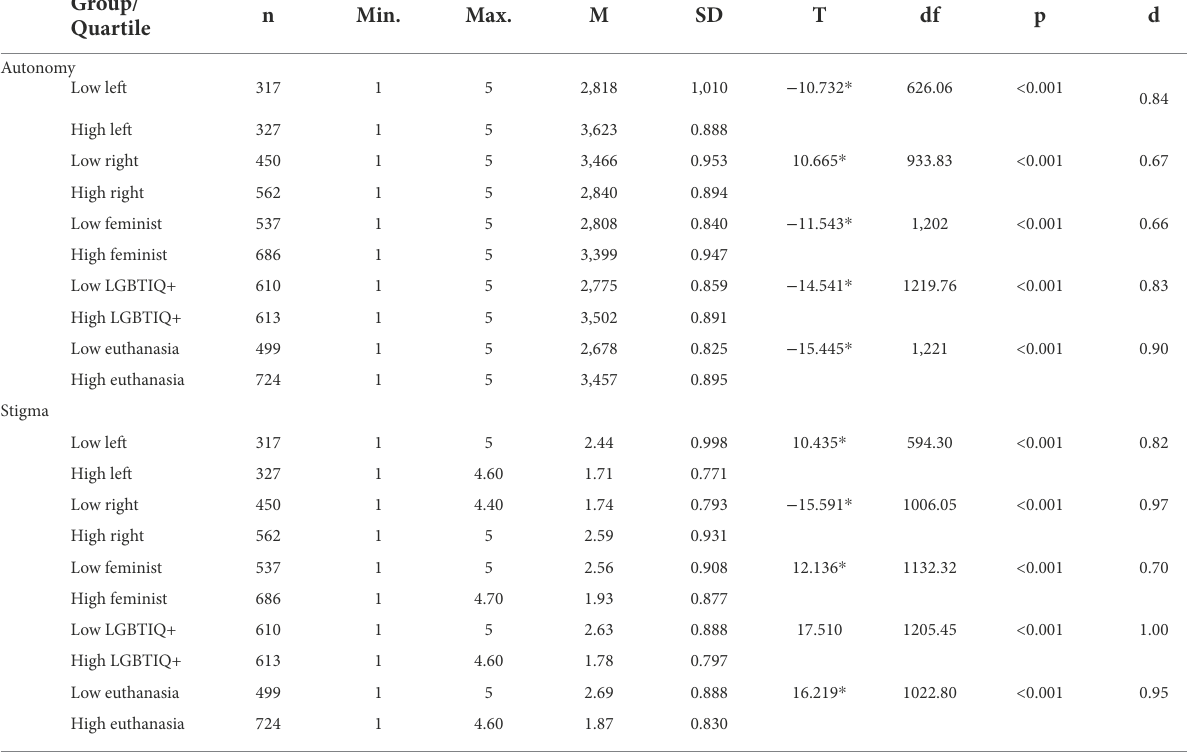
TABLE 5 Comparison between extreme groups in their scores in the dimensions of the CAAS. Group/